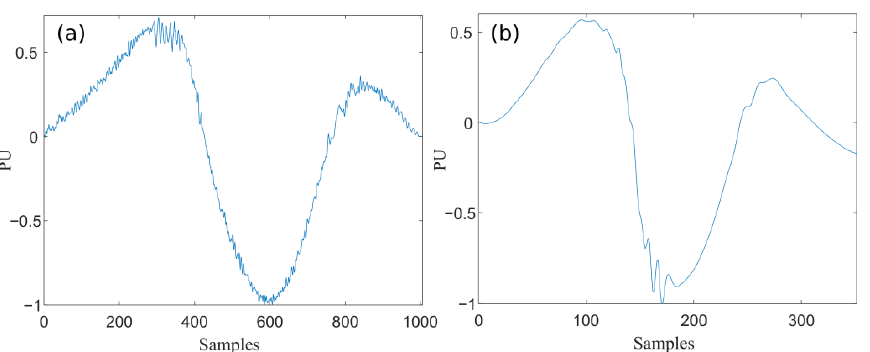
Figure 15. The IMF summation of the modes from Figure 14. ( a ) The resulting signal after summing the IMFs 1, 5, 6 and 7 of the experimental signal. ( b ) The resulting signal after summing the IMFs 1 to 5 of the simulation signal. The amplitude of both signals is normalized to observe the similarity. PU stands for per unit .